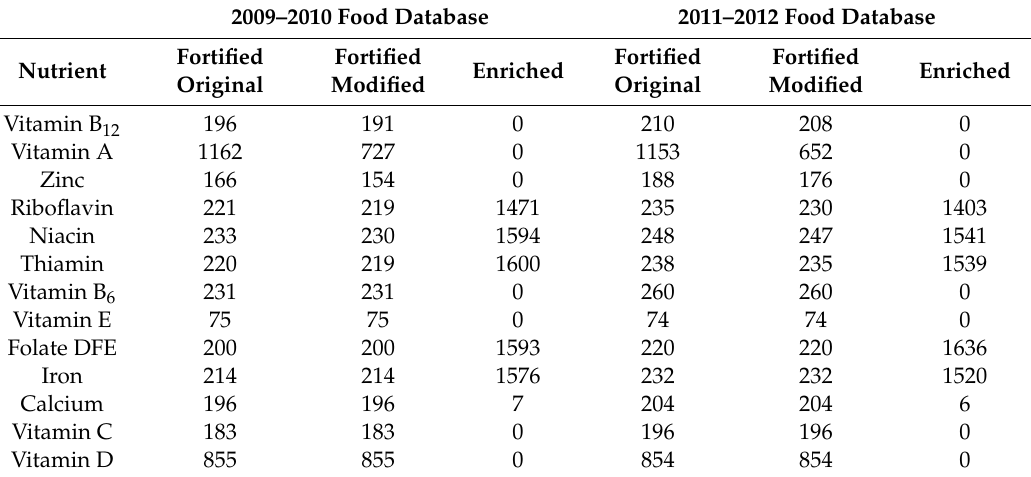
Table 2. Number of foods that are fortified and enriched with specific nutrients in the Original Food Database and predicted in the Modified Food Database, NHANES 2009–2010 and 2011–2012 for the US adult population aged ≥ 19 years 1